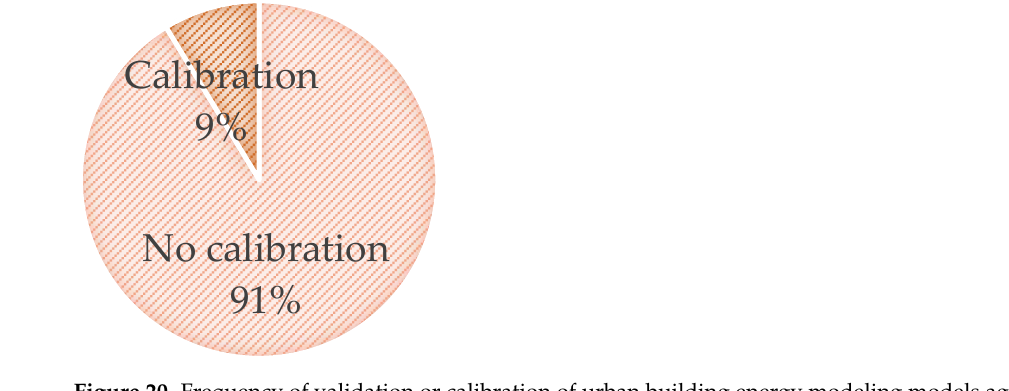
Figure 20. Frequency of validation or calibration of urban building energy modeling models against the measured data.